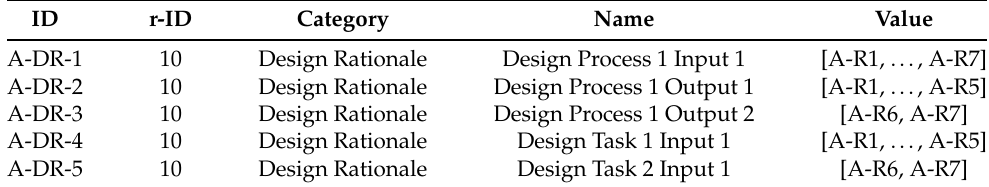
Table A5. Annotated Design Rationale for the bike crank use case.